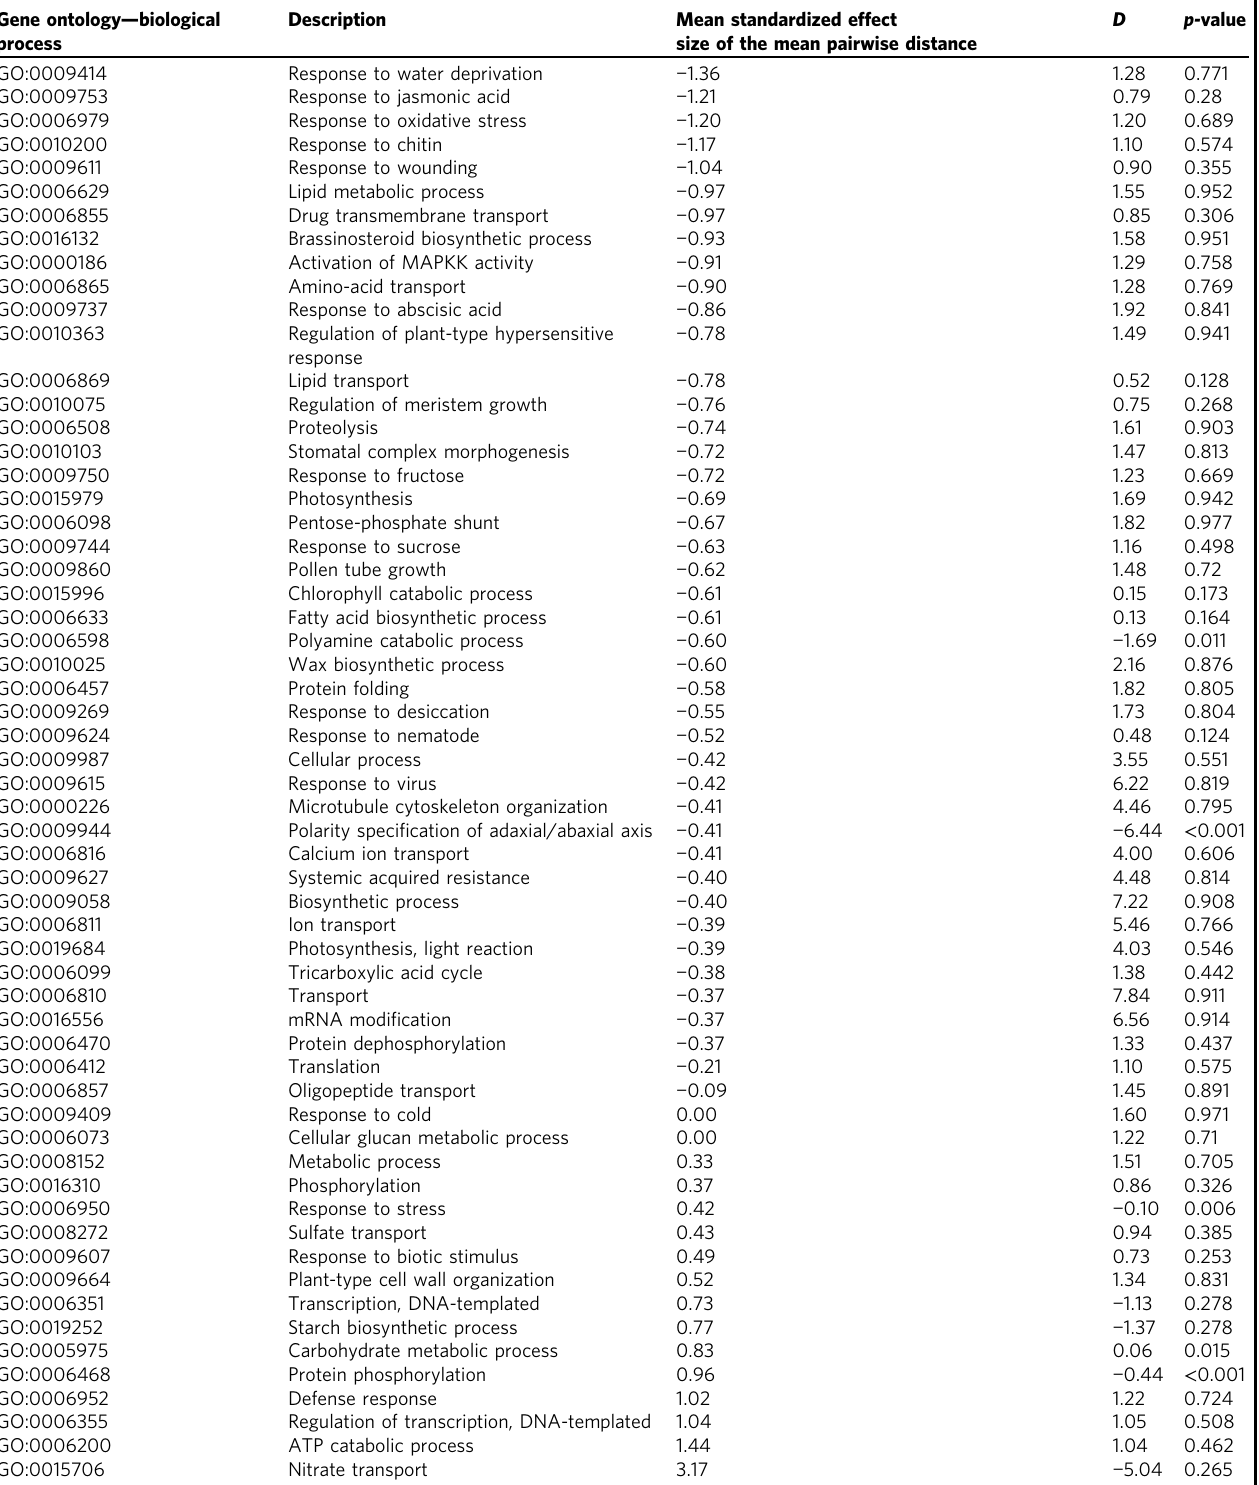
Table 1 The biological process gene ontologies analyzed in this study Gene ontology — biological